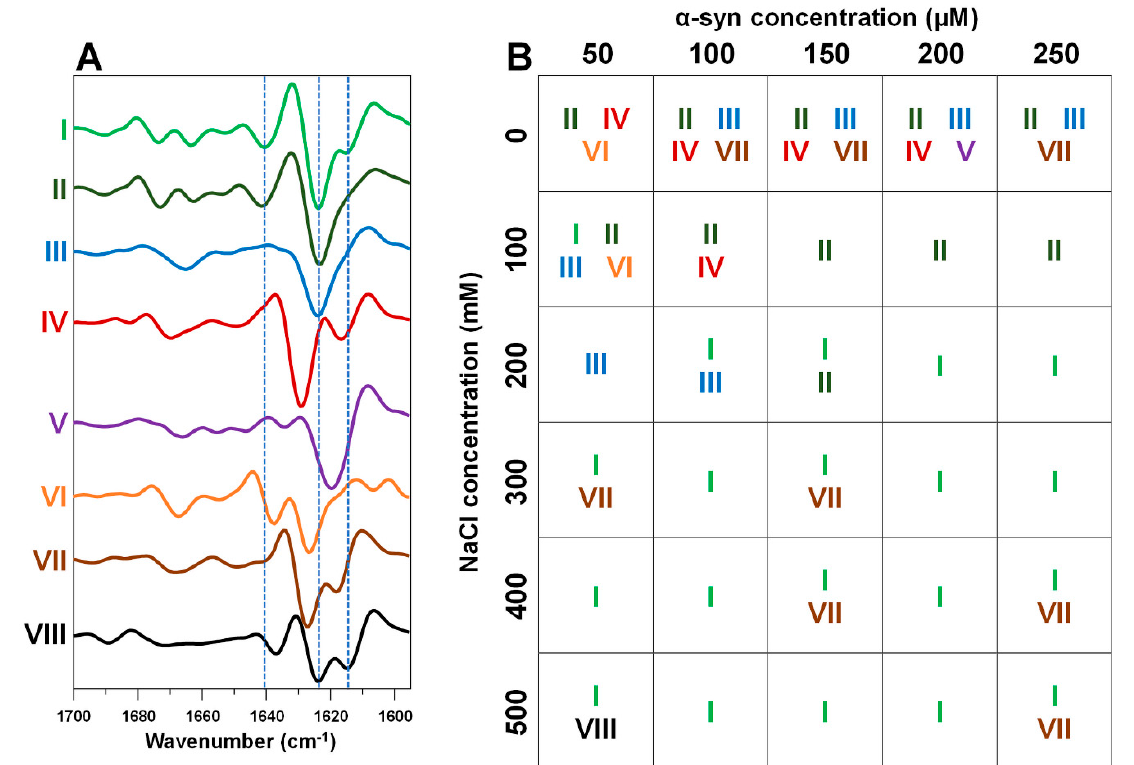
Figure 4. Second derivative FTIR spectra of fringe and outlier α -syn fibril samples ( A ). Samples from all thirty conditions were replicated in their respective initial reaction solutions in order to obtain higher quantity of fibrils for a better quality FTIR spectra and to ensure their replication. Conditions where these spectra were observed ( B ), with each spectrum assigned with a color-coded Roman numeral. FTIR raw data are available as Supplementary Material.